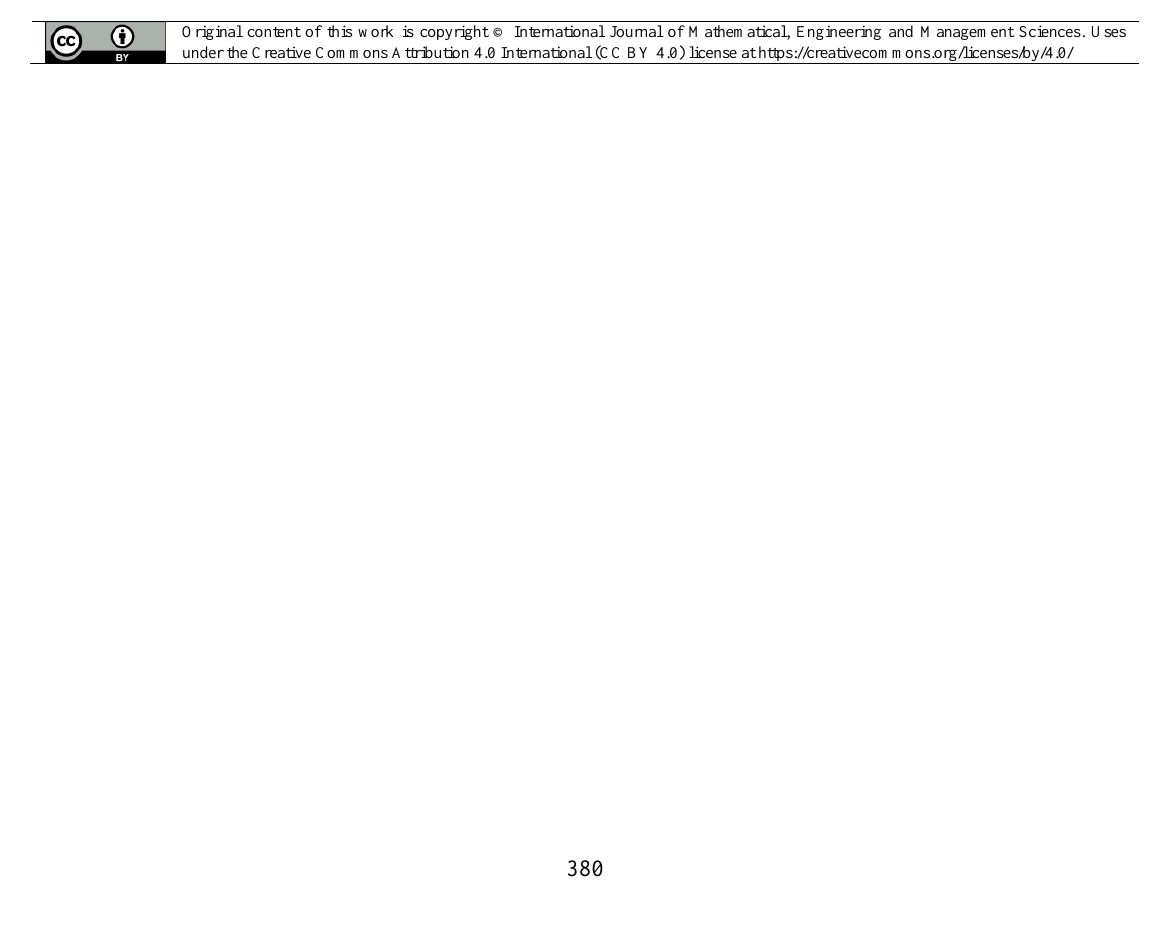
for different values of 𝜇 2